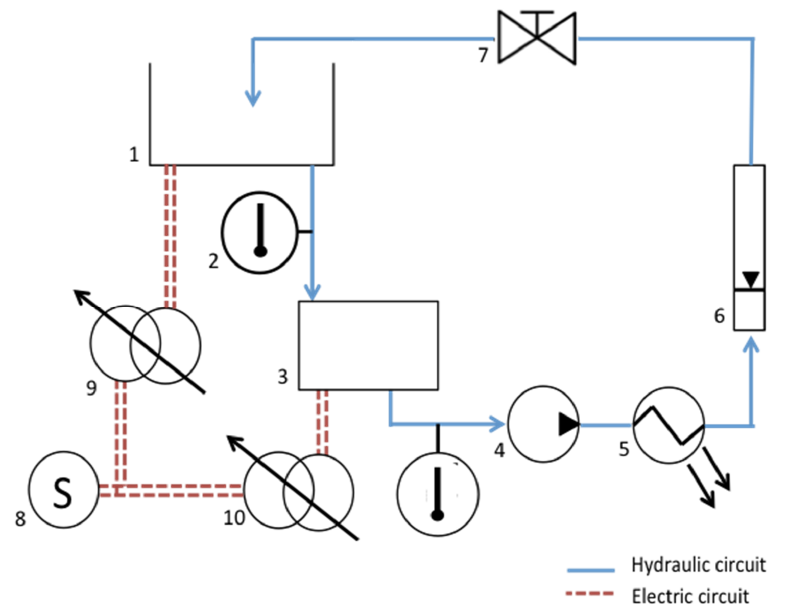
Figure 15. Test setup with (1) oil reservoir, (2) temperature sensors, (3) test box, (4) pump, (5) heat exchanger, (6) variable area flow meter, (7) globe valve, (8) AC power supply, (9) variable trans- former powering fluid heater, (10) and the variable transformer powering pole piece heaters.